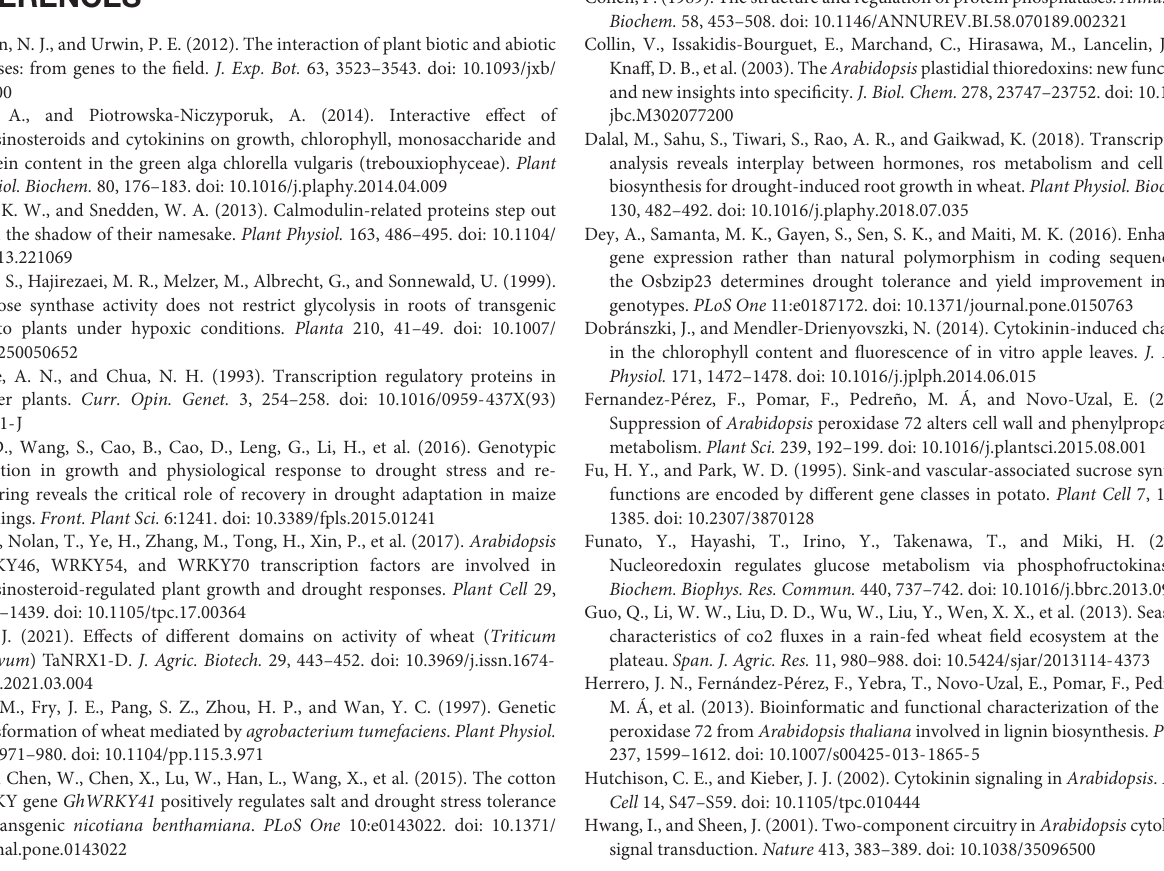
treatment 0 and 6 h. DEG set, the name of the differentially expressed genes set; DEG number, the number of differentially expressed genes; up-regulated, the number of up-regulated genes; down-regulated, the number of down-regulated genes. W0, wild type drought stress 0 h; W6, wild type drought stress 6 h; E0, TaNRX1-OE-3 drought stress 0 h; E6, TaNRX1-OE-3 drought stress 6 h; R0, TaNRX1-RNAi-6 drought stress 0 h; R6, TaNRX1-RNAi-6 drought stress 6 h. Supplementary Figure 5 | Venn diagrams of differentially expressed genes in WT and transgenic wheat lines before and after drought stress. W0, wild type drought stress 0 h; W6, wild type drought stress 6 h; E0, TaNRX1-OE-3 drought stress 0 h; E6, TaNRX1-OE-3 drought stress 6 h; R0, TaNRX1-RNAi-6 drought stress 0 h; R6, TaNRX1-RNAi-6 drought stress 6 h. Supplementary Figure 6 | RT-qPCR verification of RNA-seq results. (A) Relative expression of 70 kDa heat shock protein. (B) Relative expression of WPI6 gene. (C) Relative expression of receptor-like protein kinase. (D) Relative expression of triosephosphate isomerase. (E) Relative expression of chloroplast a/b binding protein. (F) Relative expression of protein phosphatase 2C. (G) Relative expression of UDP-glucose-6-dehydrogenase. Data represent the mean ± SD ( n = 3). E0, TaNRX1-OE-3 drought stress 0 h; E6, TaNRX1-OE-3 drought stress 6 h; R0, TaNRX1-RNAi-6 drought stress 0 h; R6, TaNRX1-RNAi-6 drought stress 6 h. The 2 − (cid:49)(cid:49) CT method was used to calculate the relative expression levels of genes. Supplementary Table 1 | All primers used in the experiment. Supplementary Table 2 | Nucleoredoxin (NRX) and TRX members off-target RNA-seq data. W01–W02, wild type drought stress 0 h two biological